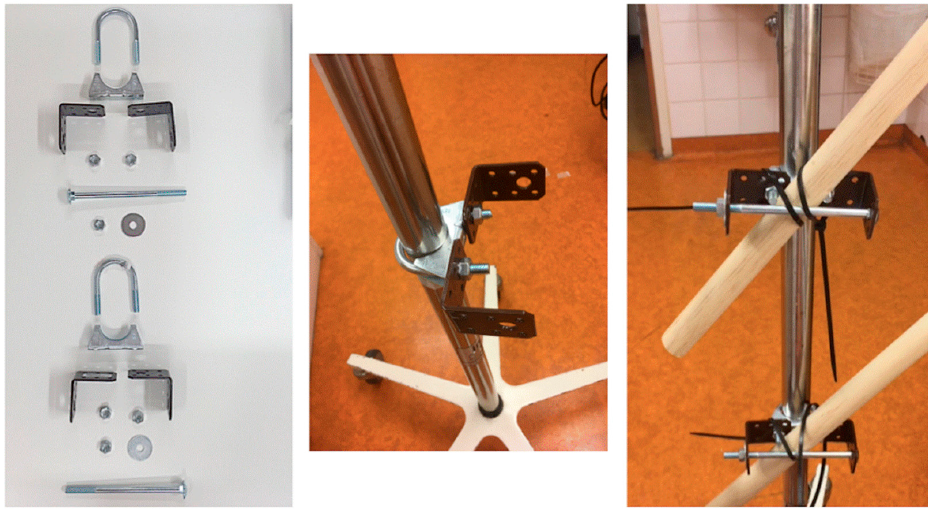
Figure 2. Construction of Tilted modality. Photo by author.